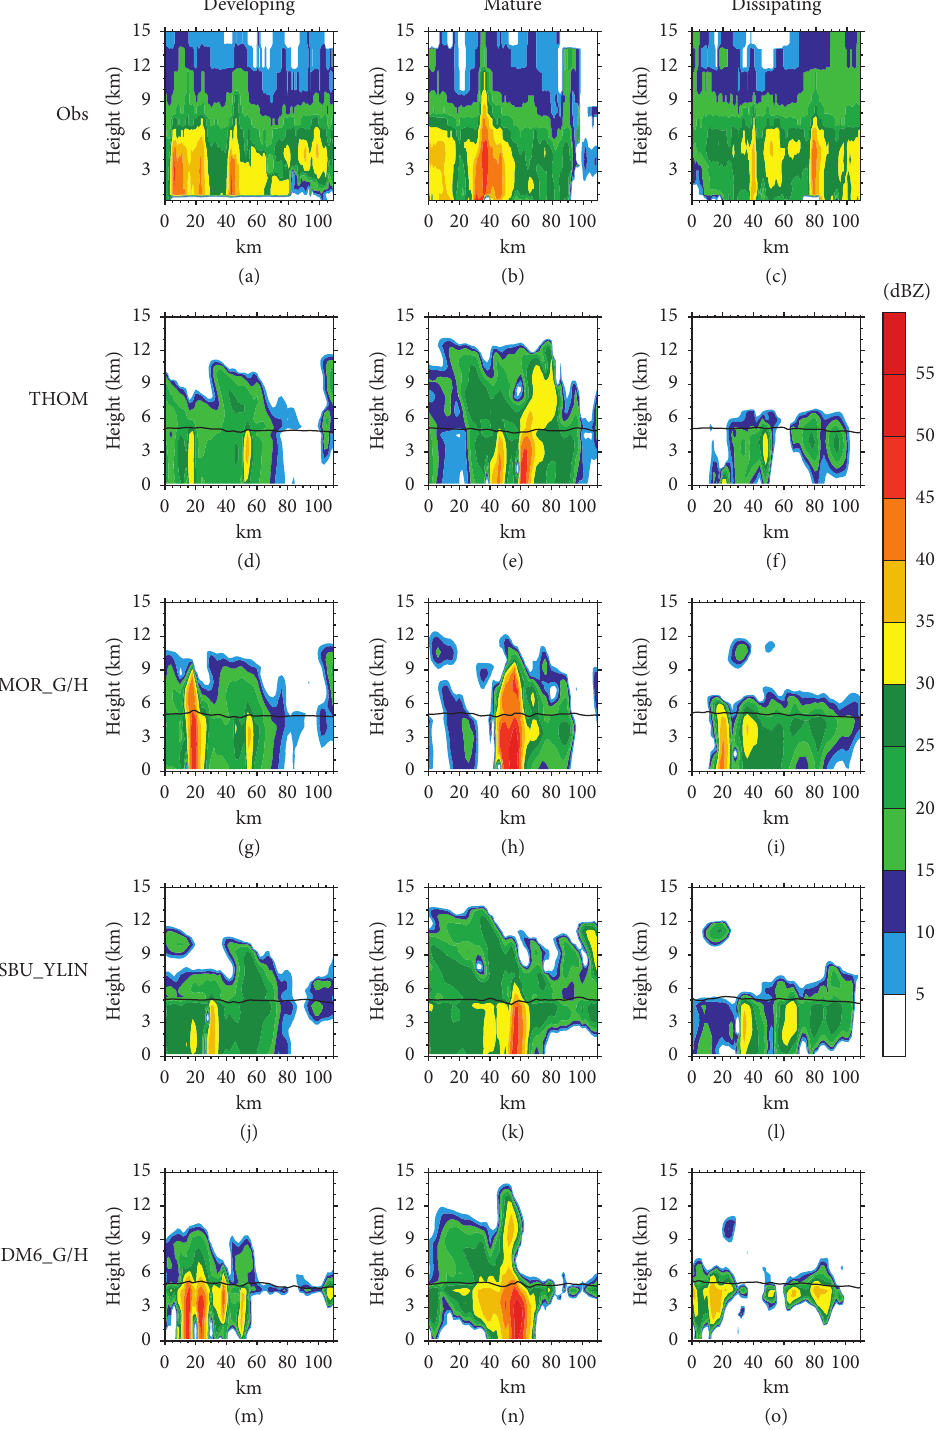
Figure 9: Cross section of radar reflectivity (in dBZ) along the black lines in Figure 7 from (a), (b), (c) observations and simulations of (d), (e), (f) THOM; (g), (h), (i) MOR_G/H; (j), (k), (l) SBU-YLIN; and (m), (n), (o) WDM6_G/H during developing (the first column), mature (the second column), and dissipating (the third column) stage. The black solid lines in simulations denote the 0 ° C scheme simulates almost the same vertical graupel distri- four simulated vertical distributions of snow are also similar bution as the observation, but fewer ice particles. MOR_G/H to the observation. However, there are many discrepancies scheme simulates more graupel than observation. The found in the graupel and ice vertical distribution. THOM